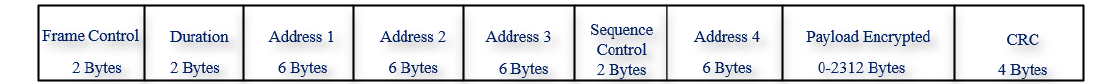
Figure 1. Wireless local area network (WLAN) frame structure (IEEE 802.11 standard frame format).